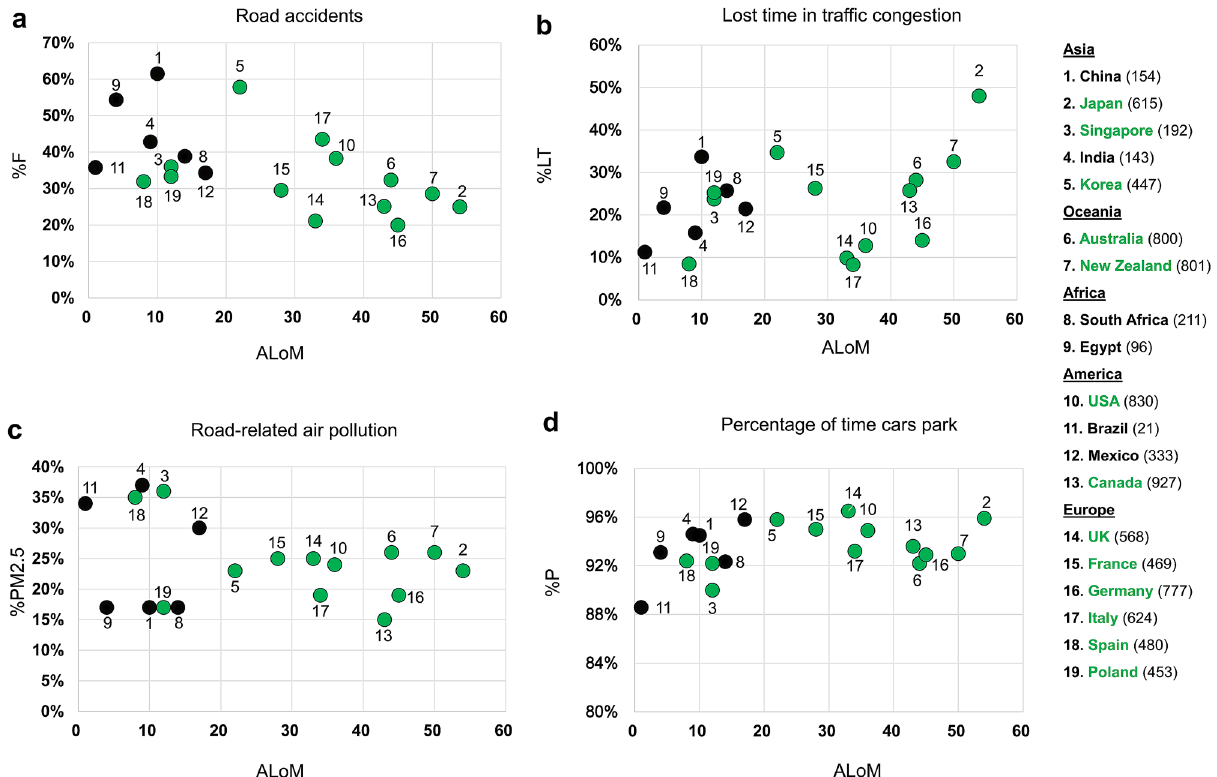
Figure 1. Measures of damages and detrimental impact of road traffic (Supplementary Tables 1 and 8). ( a ) %F is the percentage of road accident fatalities out of the total death rate from accidents of any kind. The ALoM, represents the active level of PC motorization, relates to nonstop (24/7) PCs per 1000 inhabitants. Data points and the list of 19 countries are marked in black for developing countries and green for developed countries. The number in parentheses for each country is the level of PC motorization per 1000 inhabitants, LoM. ( b ) %LT is the percent of lost time in traffic congestion out of total commuting time. ( c ) %PM2.5 is the percent of this type of air pollution from road traffic, from the total %PM2.5 produced. ( d ) %P is the average percentage of time PCs spend